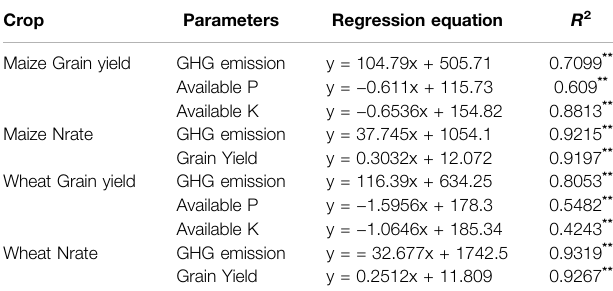
TABLE 6 | Regression equation among different parameters (yield of maize and wheat with GHG emission, available P and K in soil, and various doses of nitrogen to GHG